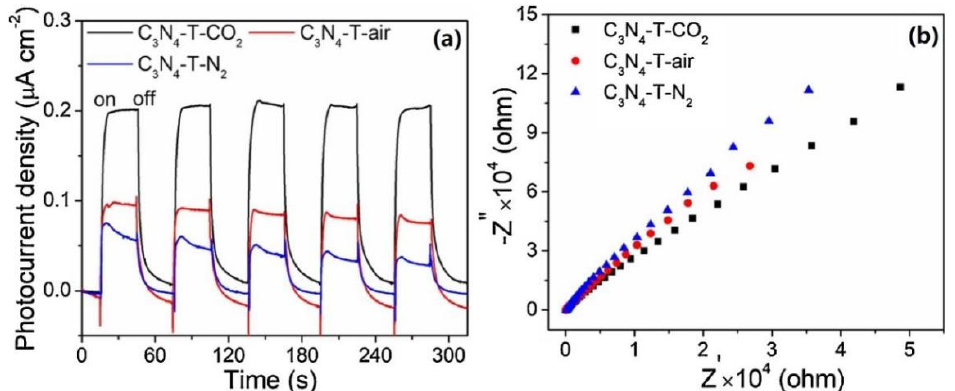
Figure 4. ( a ) Photocurrent responses and ( b ) EIS Nyquist plots of C 3 N 4 -T-Y under light irradiation. Used with permission from [94]. Copyright 2019 Elsevier.